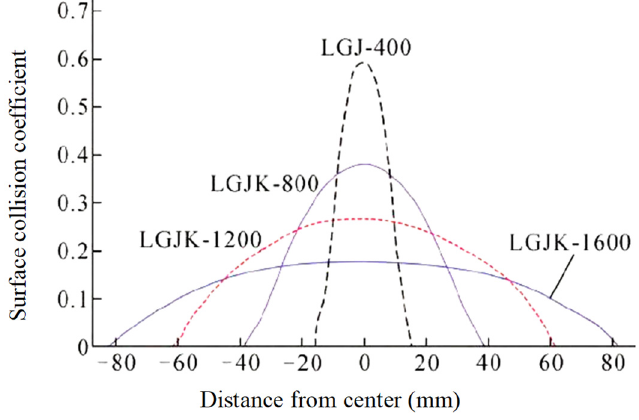
Figure 13. Local collision coefficient of different diameters conductor surface [39].